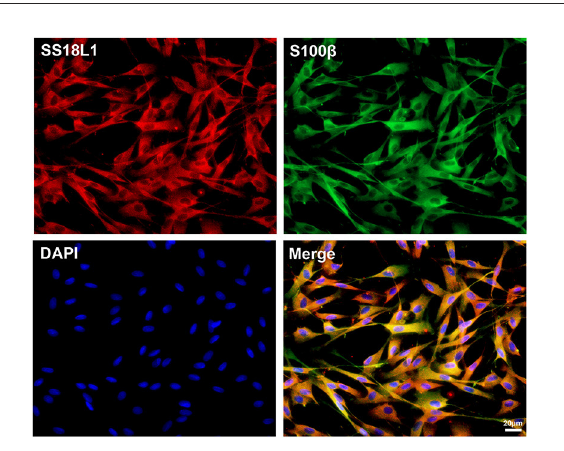
FIGURE2 Localization of SS18L1 in cultured Schwann cells. Red color indicates SS18L1, green color indicates S100 β , and blue color indicates nucleus. Scale bars indicated 20 µ